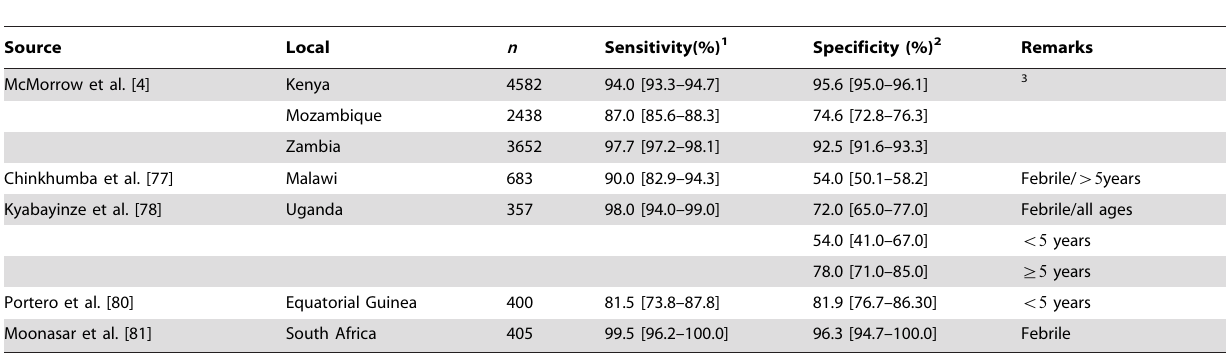
Table 5. Some information based on literature – RDT (ICT Diagnostics, Cape Town, South Africa).